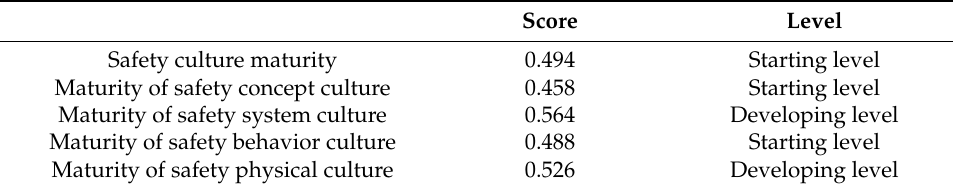
Table 7. Enterprise Safety Culture Maturity Scale to be